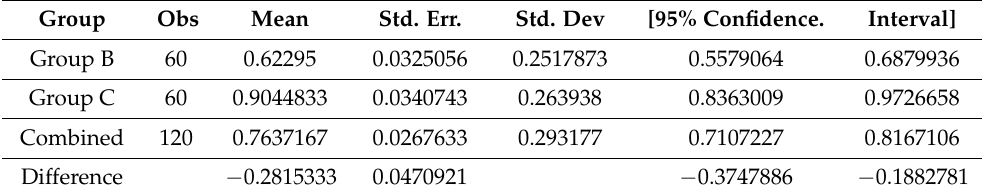
Table 5. Statistical data about differences between the two types of